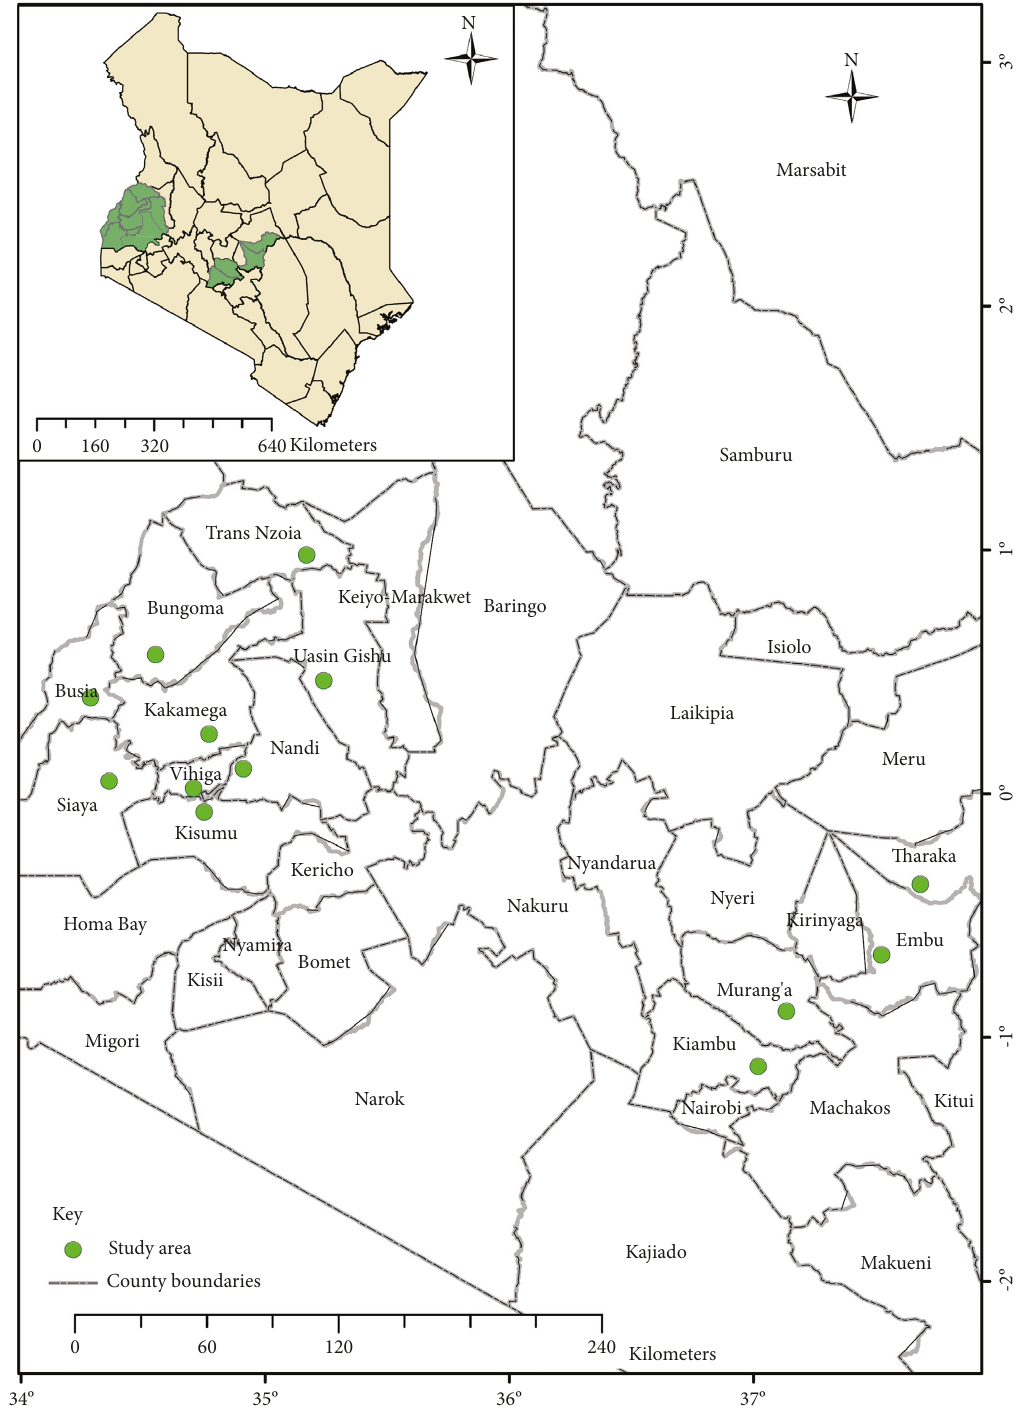
Figure 1: Sampling sites of the field populations of S. frugiperda from Kenya. The green dots represent sampling locations (Table